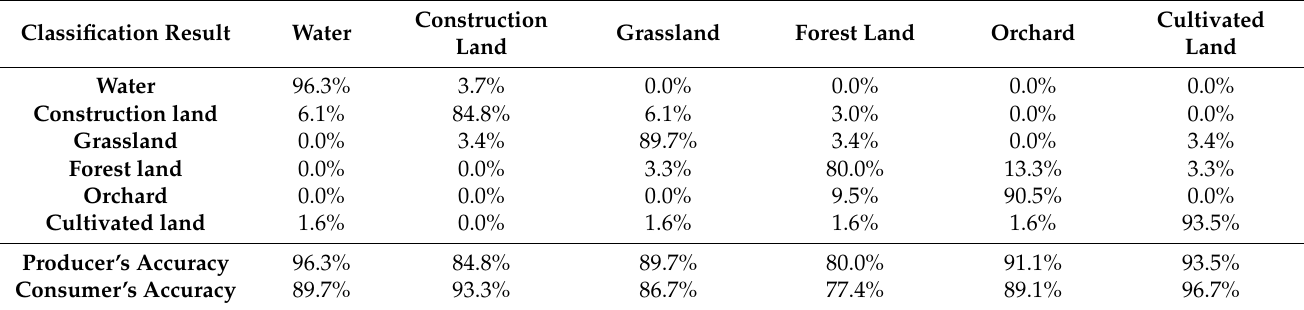
Figure 3. Standard endmember spectral curves and 2020 LSMA results. ( a ) Standard spectral information of four pure endmembers. ( b ) LMSA results in 2020. Table 1. Land use/cover classification